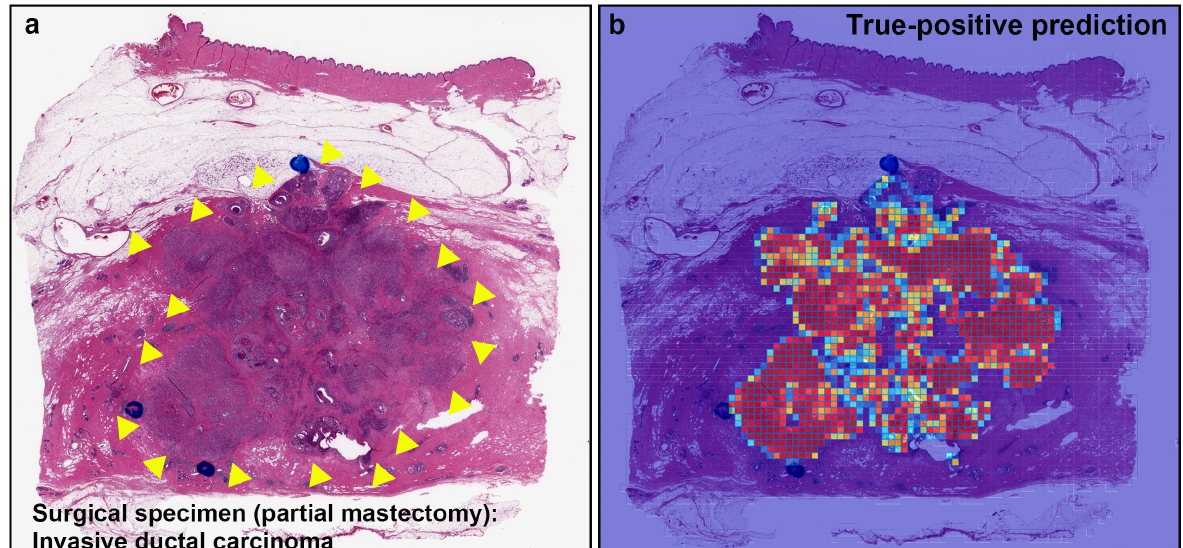
Figure 6. A representative false negative prediction output on a case from core needle biopsy test set. According to the histopathological report, this case ( a , c ) is an invasive ductal carcinoma (IDC). However, there are no true positive predictions of IDC cells on heatmap image ( b